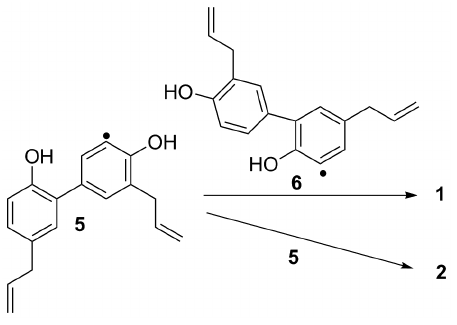
Figure 2. Plausible biosynthetic pathway to 1 and 2.